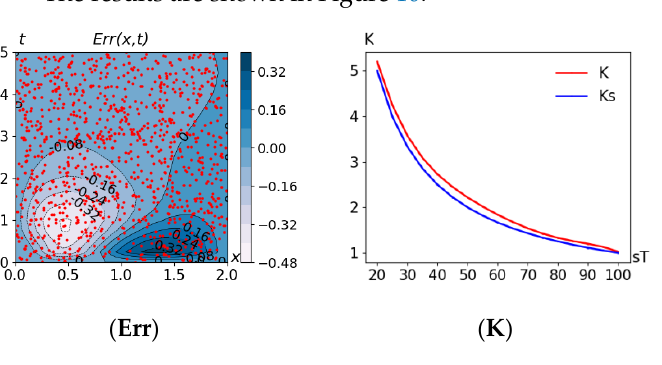
Figure 10. SvF solution of Problem 5.7: ( Err ) Err(x,t) = T(x,t)-Ts(x,t) ; ( K ) the thermal conductivity coefficient.